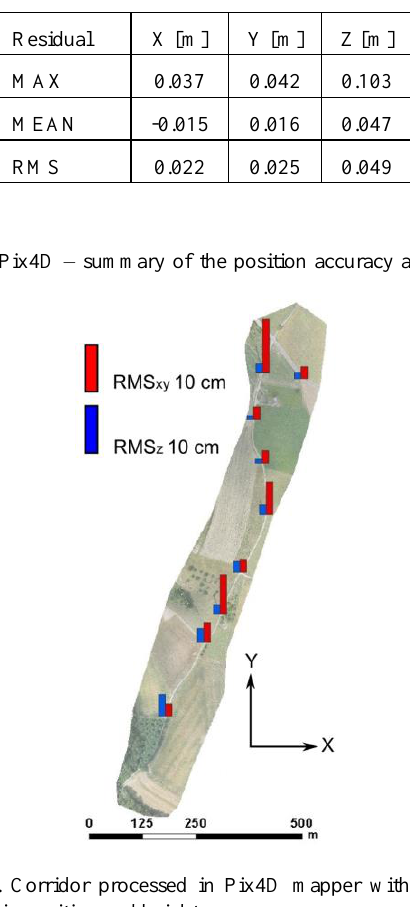
Figure 8. Corridor processed in Pix4D mapper with depicted residuals in position and height